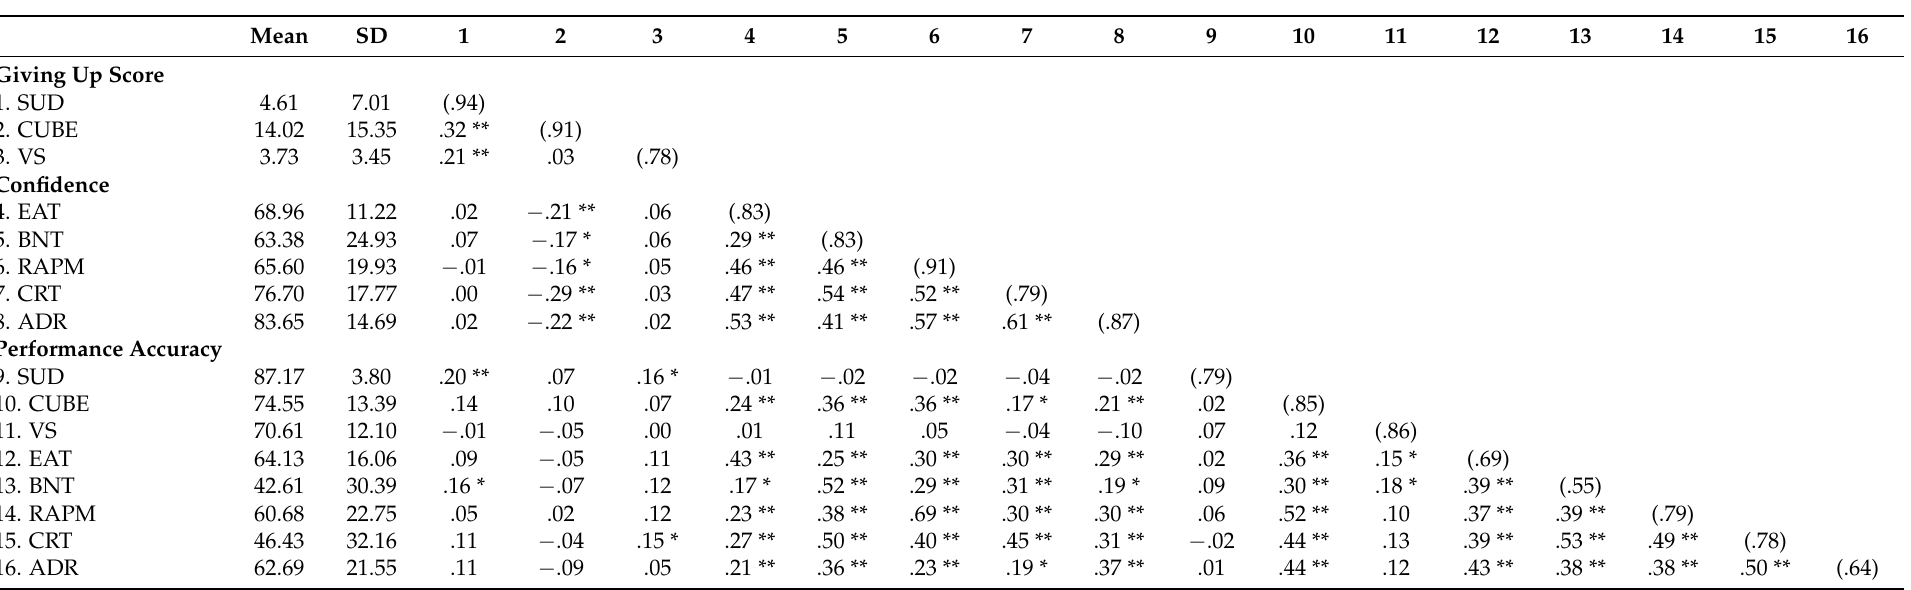
Table 2. Descriptive statistics, reliabilities, and correlations between metacognitive and cognitive